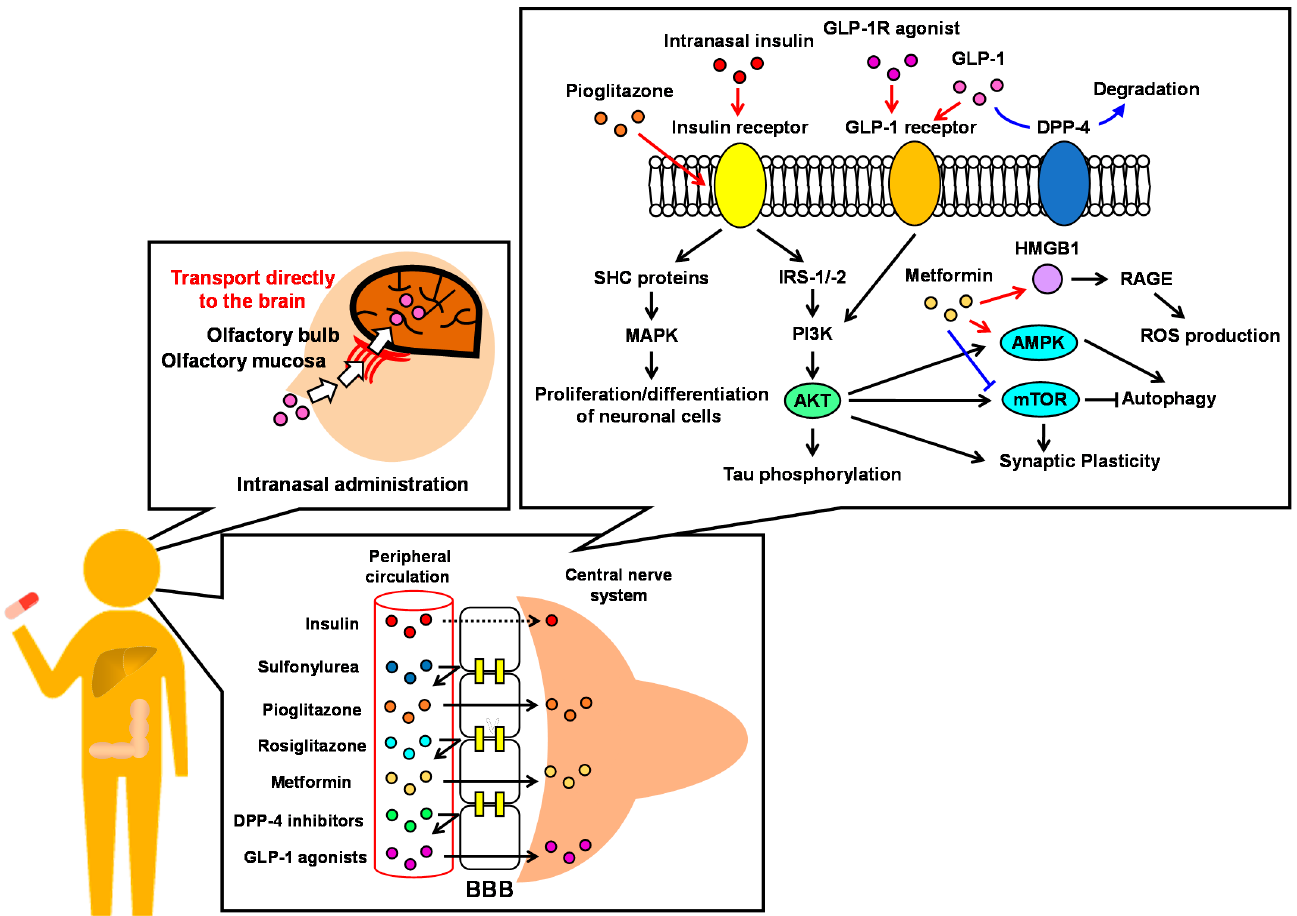
Figure 1. The pharmacological and pharmacokinetic properties of antidiabetic drugs.